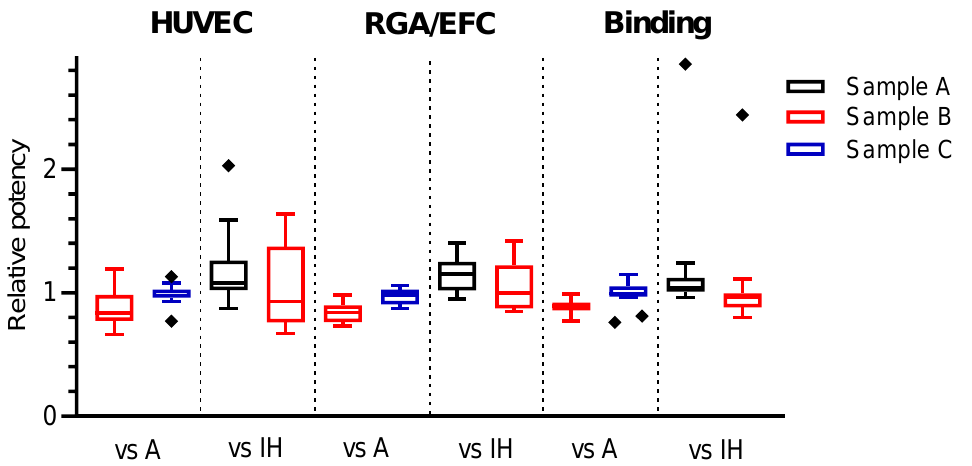
Figure 3. Laboratory geometric mean relative potency estimates calculated using either the candidate standard sample A (A) or individual in-house (IH) reference standards for VEGF neutralizing (HUVEC and RGA/EFC) and binding assays. Boxes represent the interquartile range and lines show the median. Diamonds indicate outliers. Table 9. Overall geometric mean relative potency estimates for VEGF165 neutralising and binding assays.